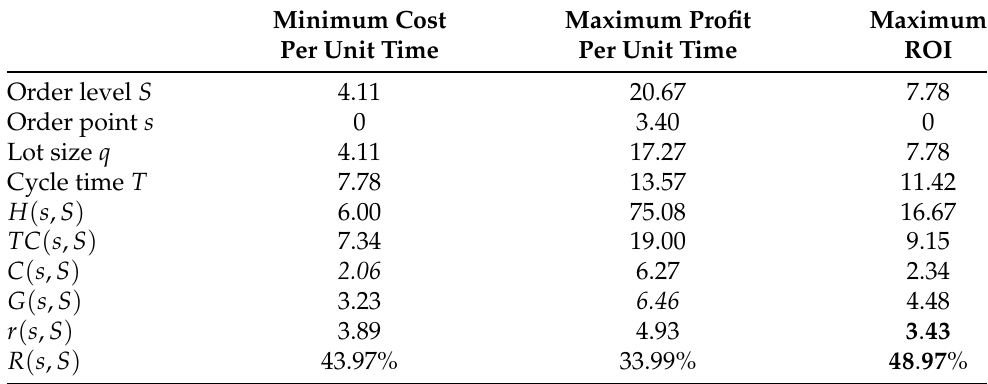
Table 3. Comparison of the three